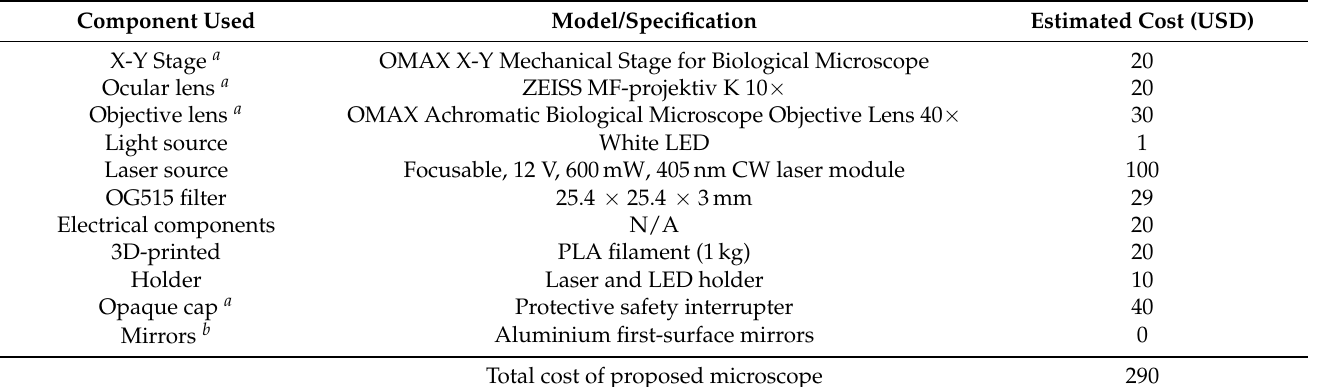
Table 1. Breakdown costs of our low-cost laser inverted fluorescence